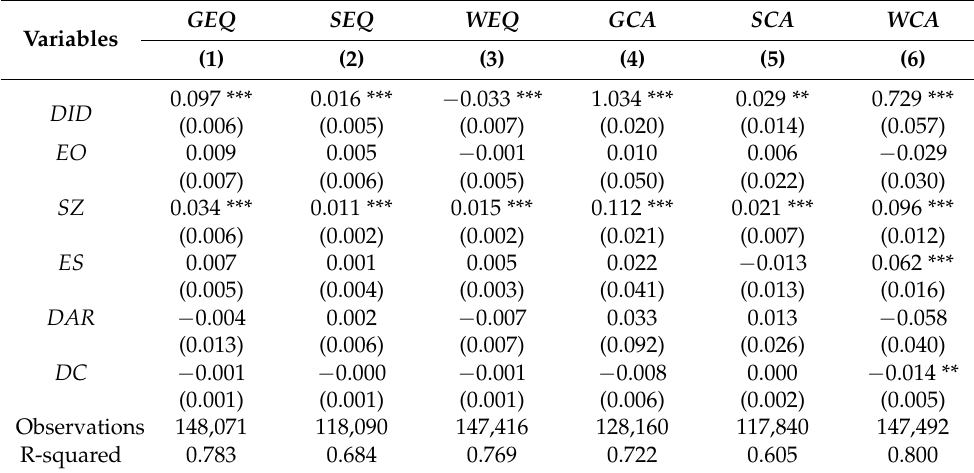
Table 3. Regression results of the terminal governance